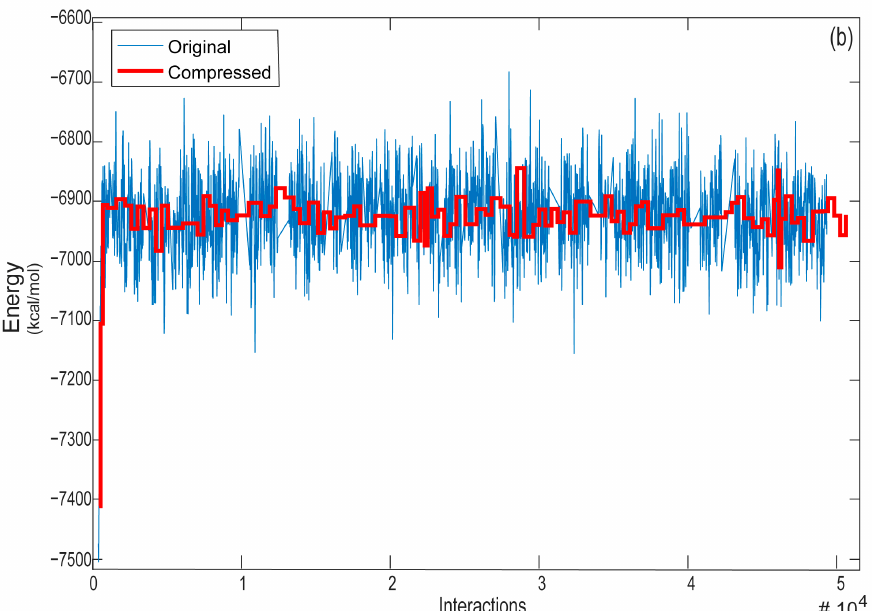
Figure 8. Energies of the systems studied (original and compressed) at each moment. ( a ) First MD with PC and PI3K; ( b ) Second MD with PC and water molecules.